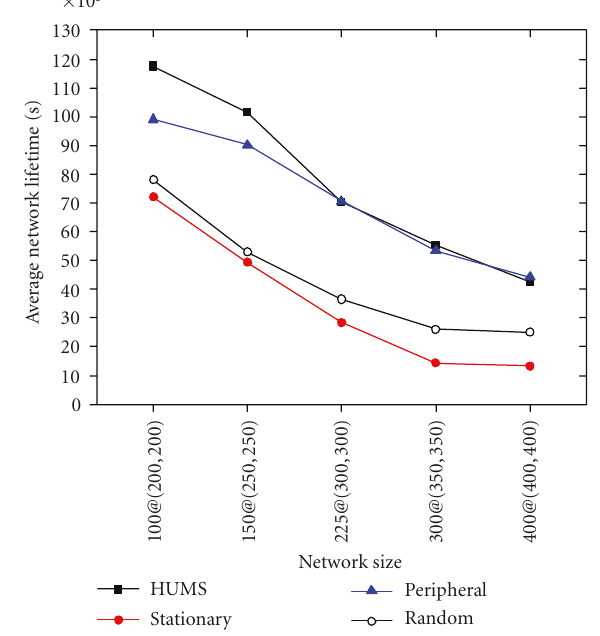
Figure 8: Network lifetimes varied with di ff erent network sizes. (The initial energy for each node is 8